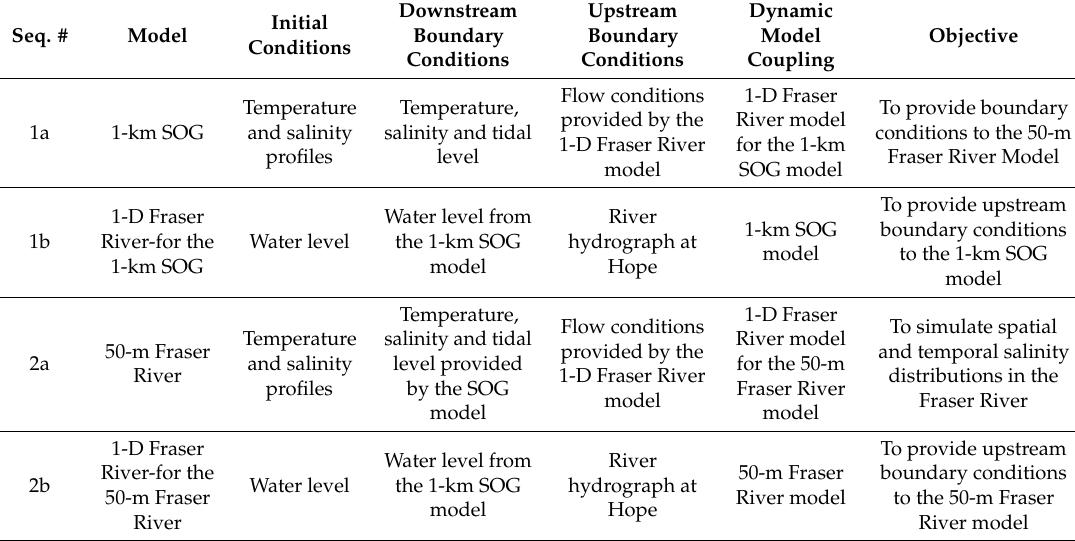
Table 1. Modelling sequence of the